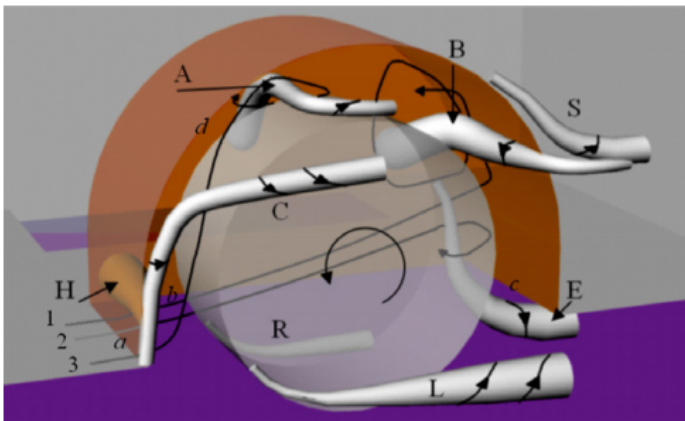
Figure 8. Vortex skeleton model of the wheelhouse flow field by Regert and Lajos